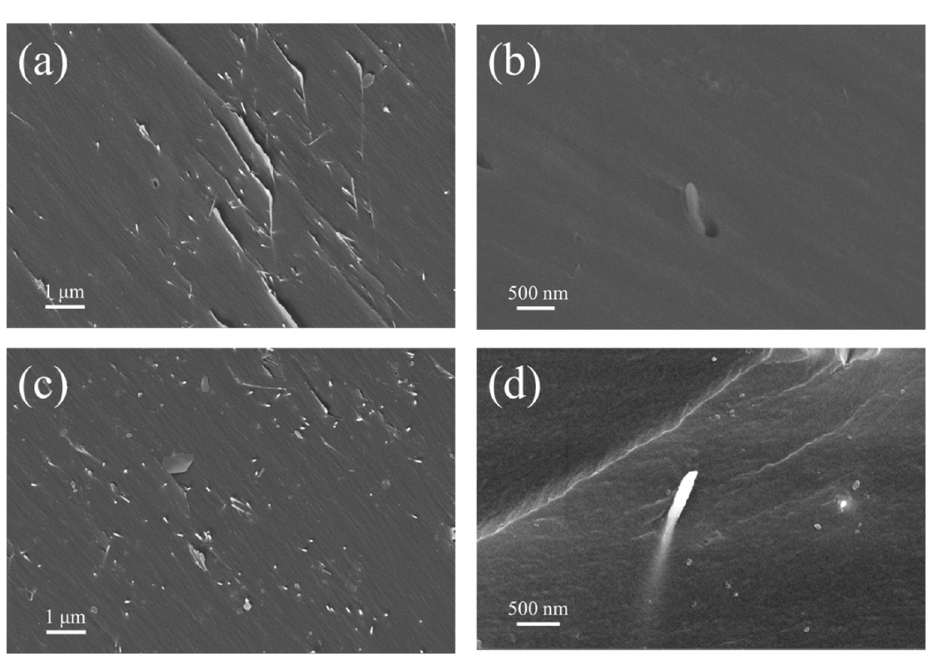
Figure 6. ( a , b ) are SEM photos of epoxy resin composite filled with AgNW; ( c , d ) are SEM photos of epoxy resin composite filled with